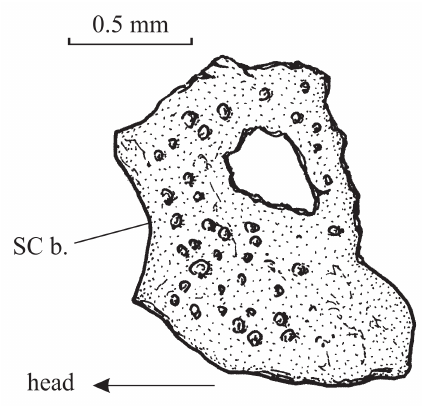
Fig. 21. Pankowskichthys libanicus gen. et sp. nov. A scute-like body scale of holotype, IRSNB